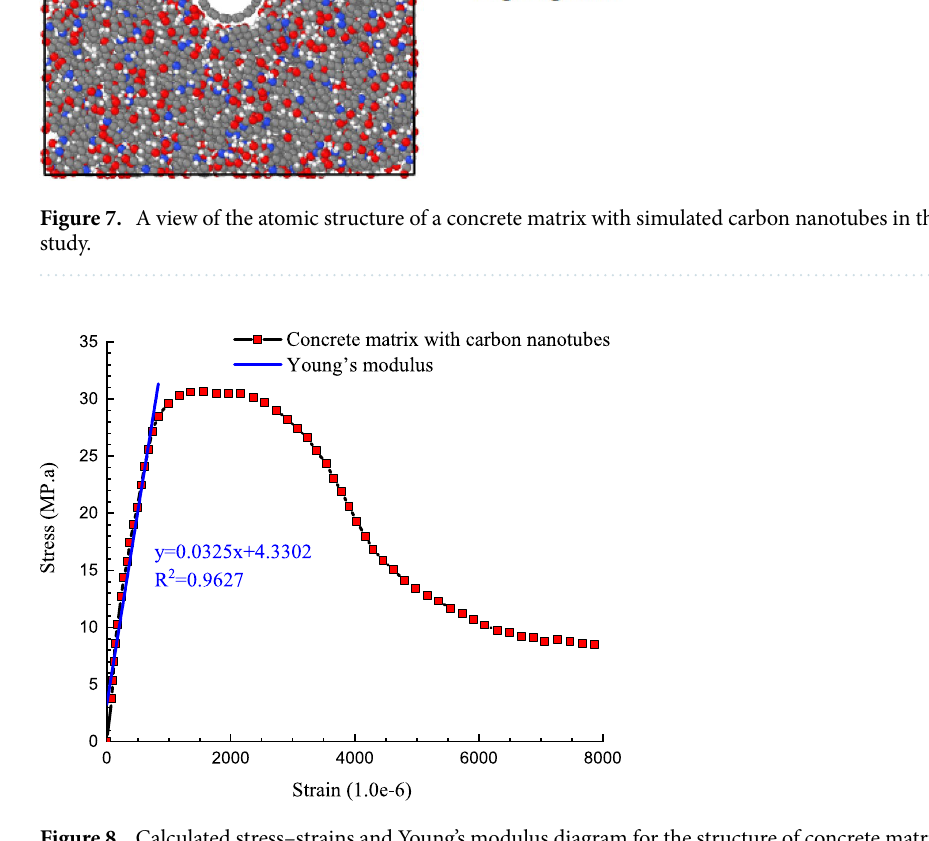
Figure 8. Calculated stress–strains and Young’s modulus diagram for the structure of concrete matrix with zig- zag carbon